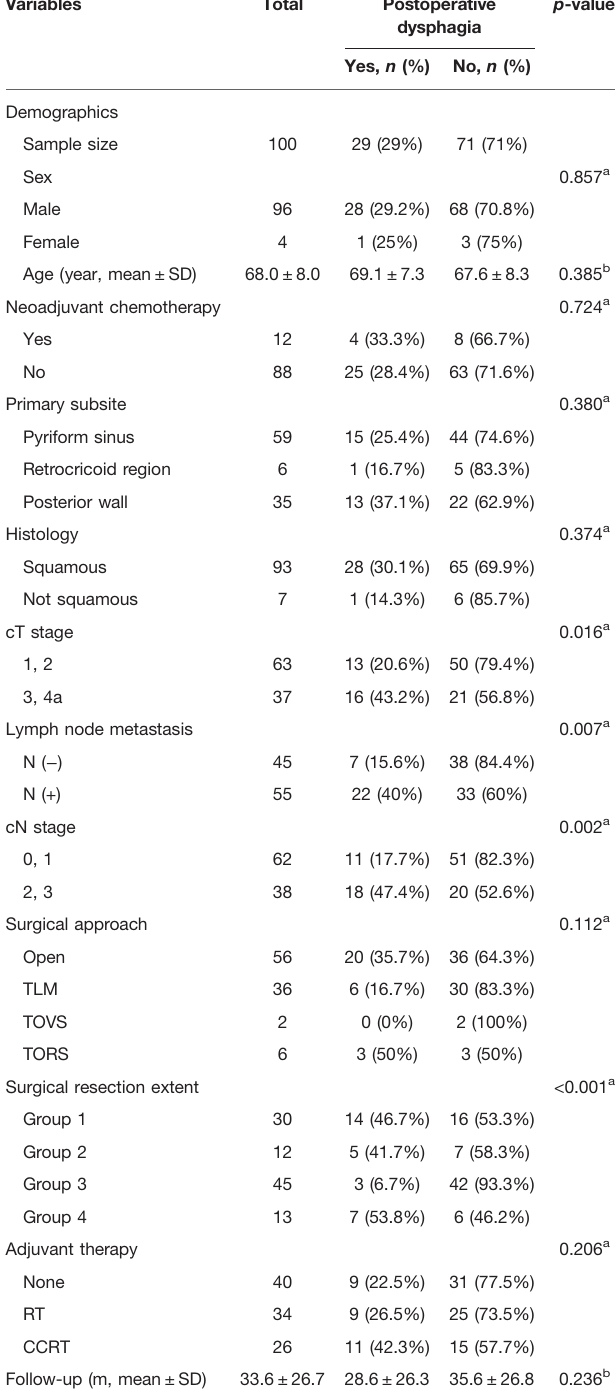
TABLE 1 | Patient characteristics and univariate